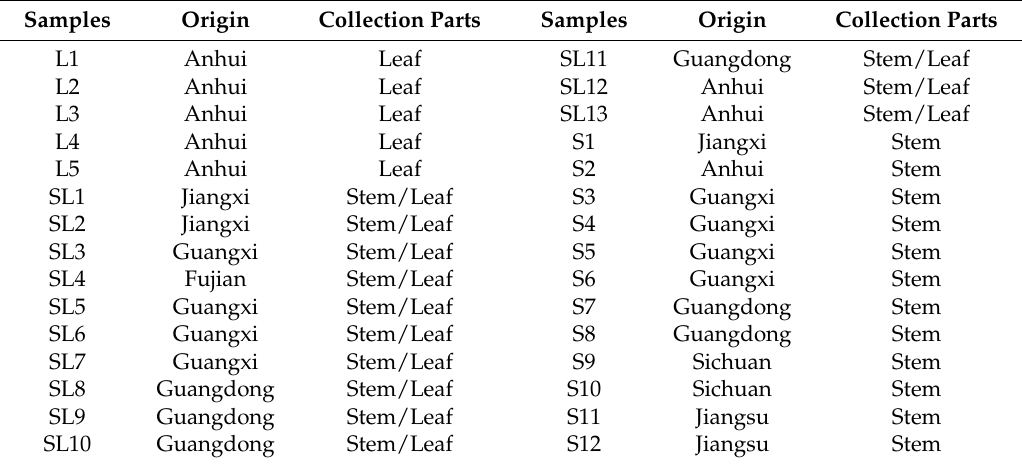
Table 3. AH collection